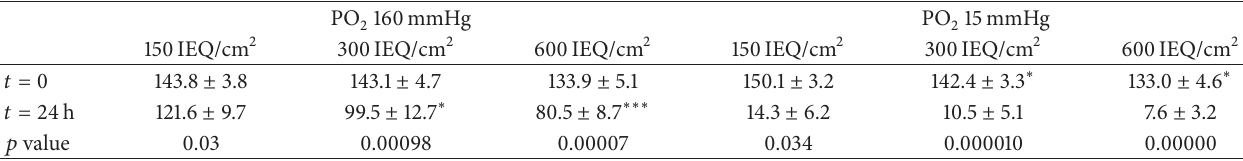
Table 2: Oxygen measurements at time 0 ( 𝑡 = 0 ) and after 24 hours ( 𝑡 = 24 h) for each islet culture density (150, 300, and 600 IEQ/cm 2 ) under normoxic (PO 2 160 mmHg) and hypoxic (PO 2 15 mmHg) conditions. The difference between 𝑇 0 and 𝑇 24 is represented by the 𝑝 values. The difference between densities within the same condition is represented by ∗